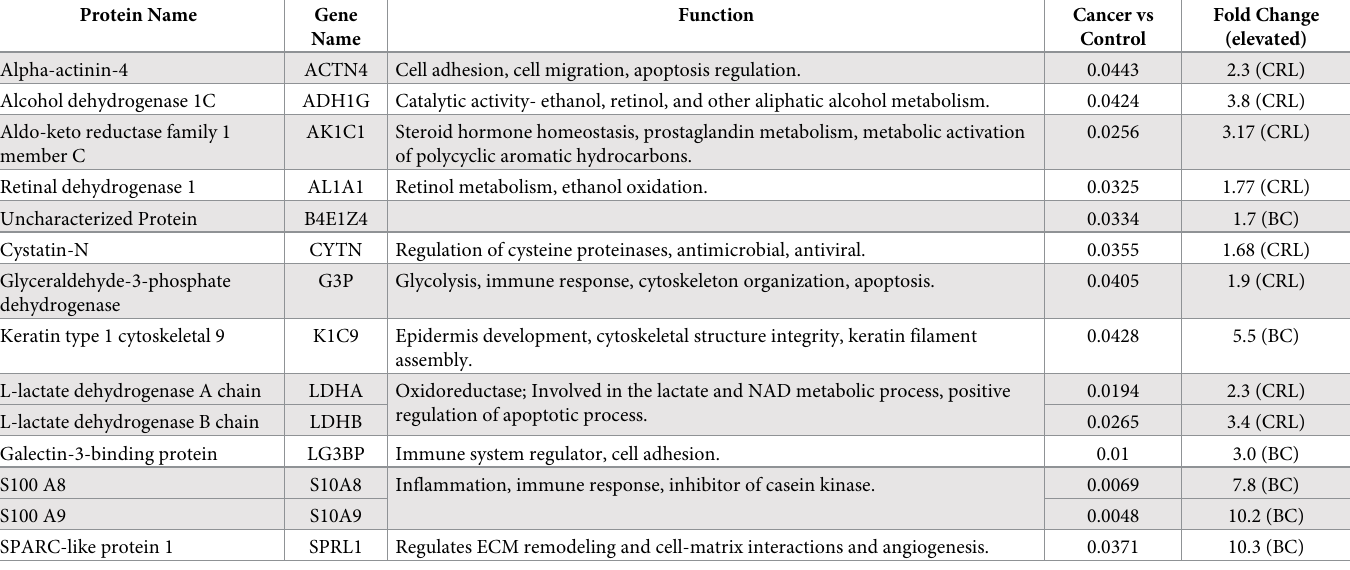
Table 4. Summary of relevant biomarkers candidates from mass spec